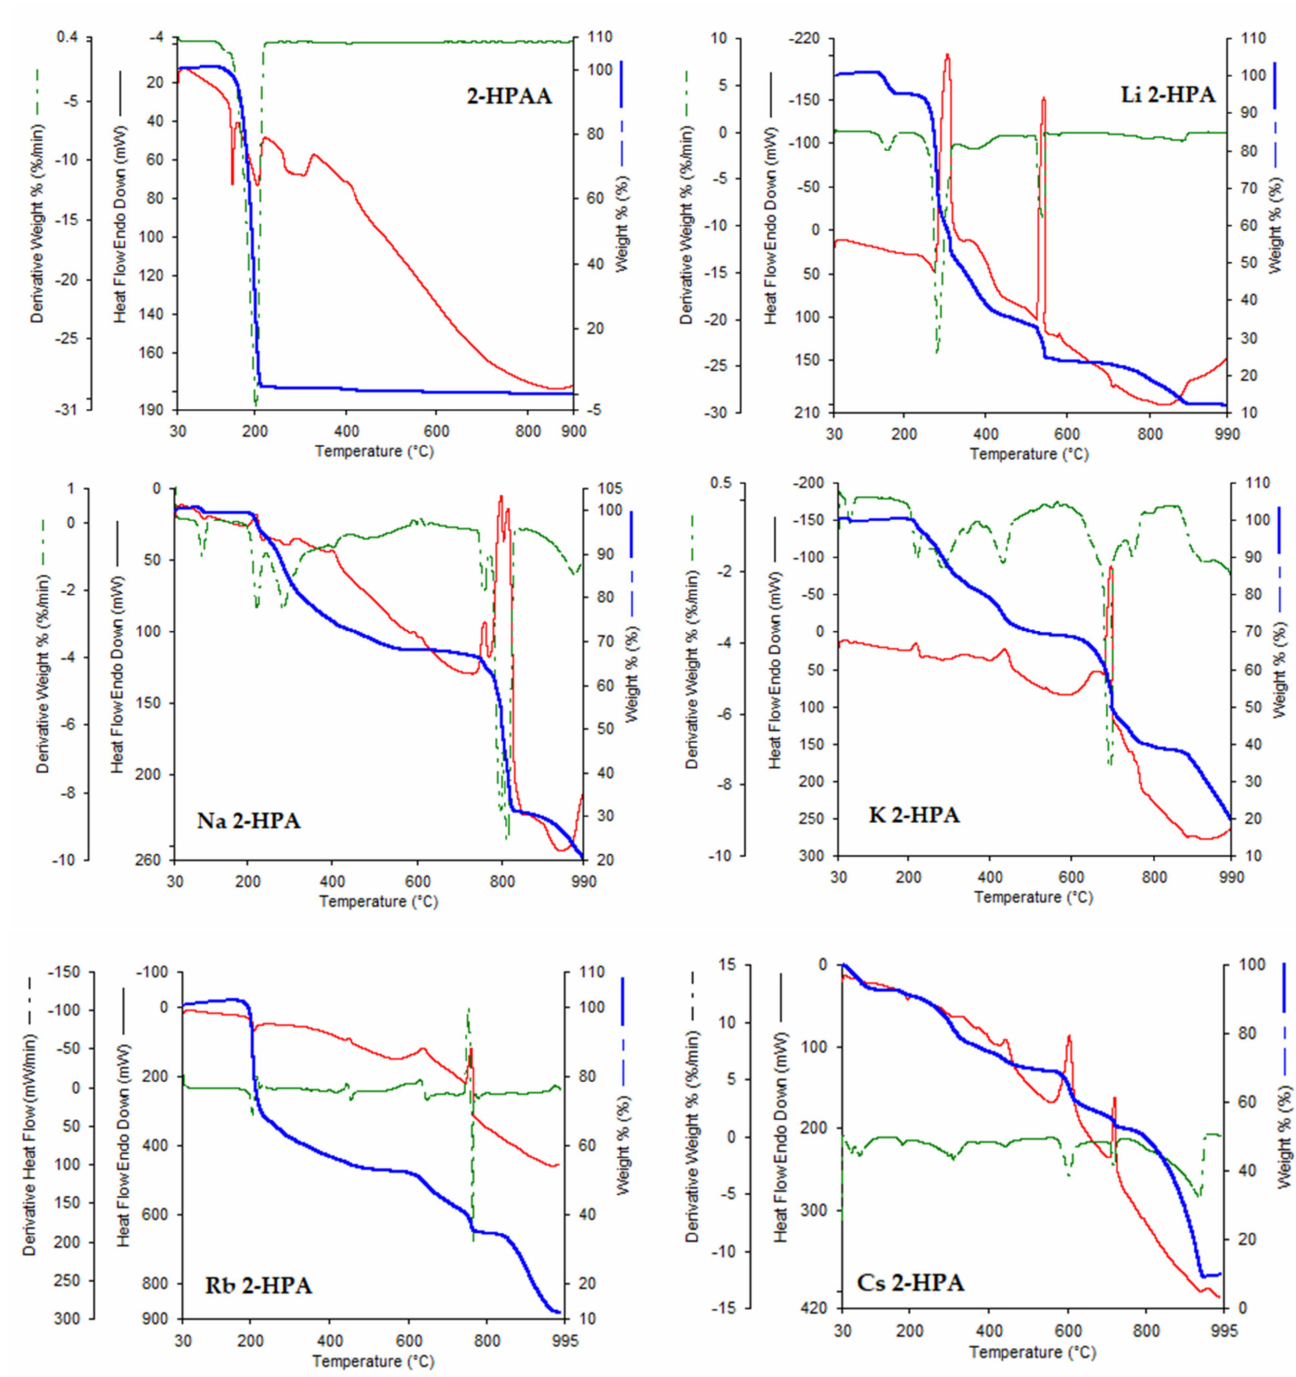
Figure 6. The DSC (red line) and TG (blue line)/TDG (green line) curves of 2-HPAA and its alkali metal salts obtained in air